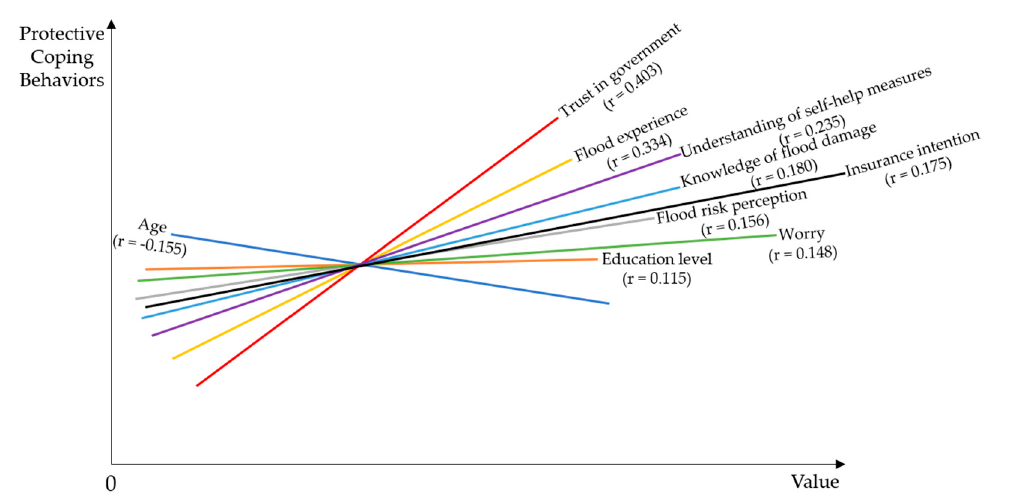
Figure 2. Schematic diagram of correlation between factors.